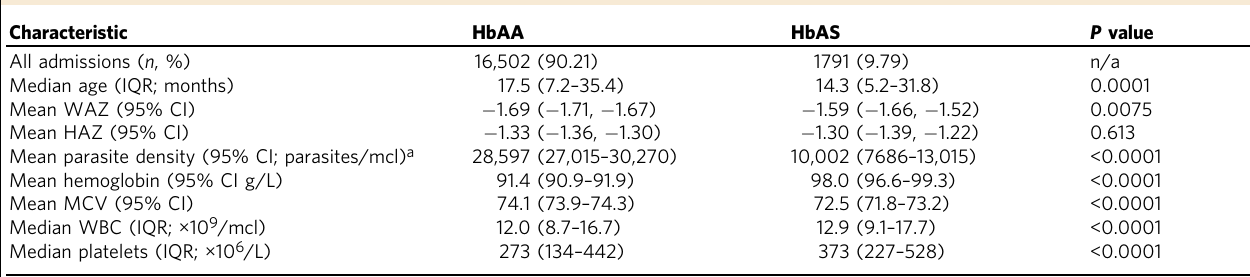
Table 1 Clinical and laboratory characteristics of case-patients Characteristic HbAA HbAS P value All admissions ( n , %)